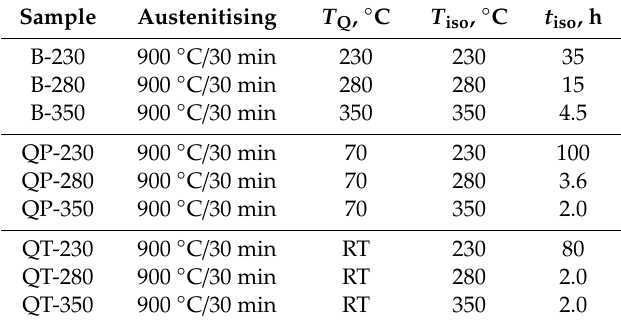
Figure 2. Scheme of the heat treatments performed to obtain bainitic, quenching and partitioning (Q&P), and quenching and tempering (Q&T) martensitic structures in the bearing steel designed. T Q is the quench temperature, T iso and t iso are the isothermal heat-treatment temperature and time, respectively, and M s and M f are the martensite start and finish temperatures, respectively. Table 4. Heat-treatments performed in Nanobain bearing steel. T Q is the quench temperature, and T iso and t iso are the isothermal heat-treatment temperature and time, respectively.